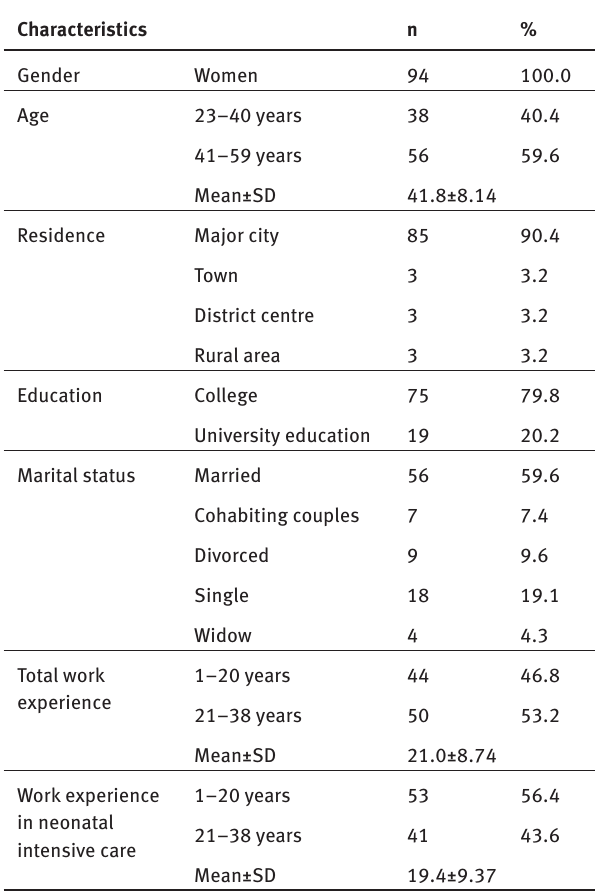
Table 1: Demographic characteristics of study sample